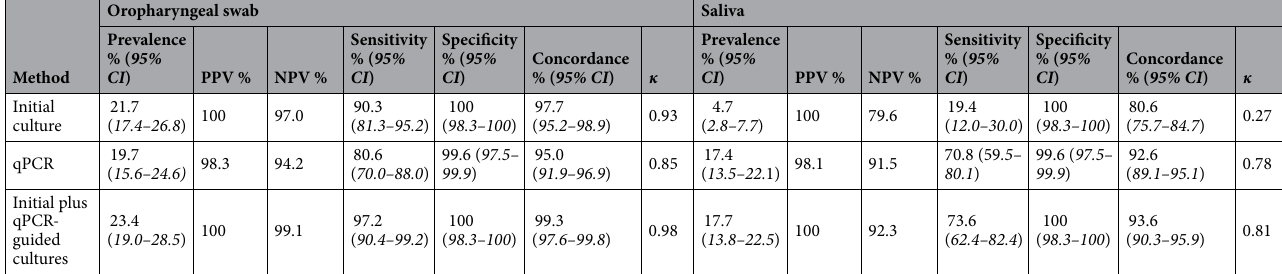
Table 1. The accuracy of Neisseria meningitidis detection in oropharyngeal and saliva samples collected from 299 students and tested with culture and using molecular methods applied to DNA extracted from culture- enriched samples. Measures of diagnostic accuracy were calculated by comparing the number of individuals positive per method with the overall number of individuals positive for N. meningitidis by any method. PPV positive predictive value, NPV negative predictive value, 95% CI 95% confidence interval, κ Cohen’s Kappa where ≤ 0, 0.01–0.20, 0.21–0.40, 0.41–0.60, 0.61–0.80, > 0.81 are interpreted as no agreement, none to slight, fair, moderate, strong, and almost perfect agreement, respectively.